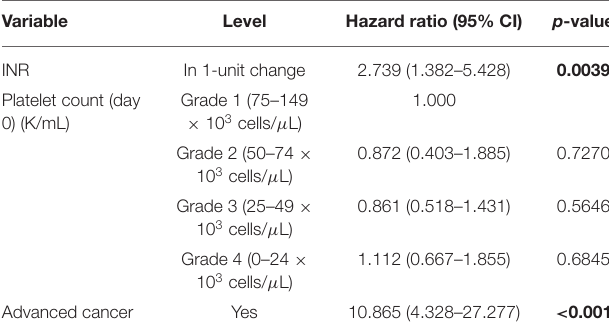
TABLE 3 | Overall survival by multivariate analysis including INR and advanced cancer